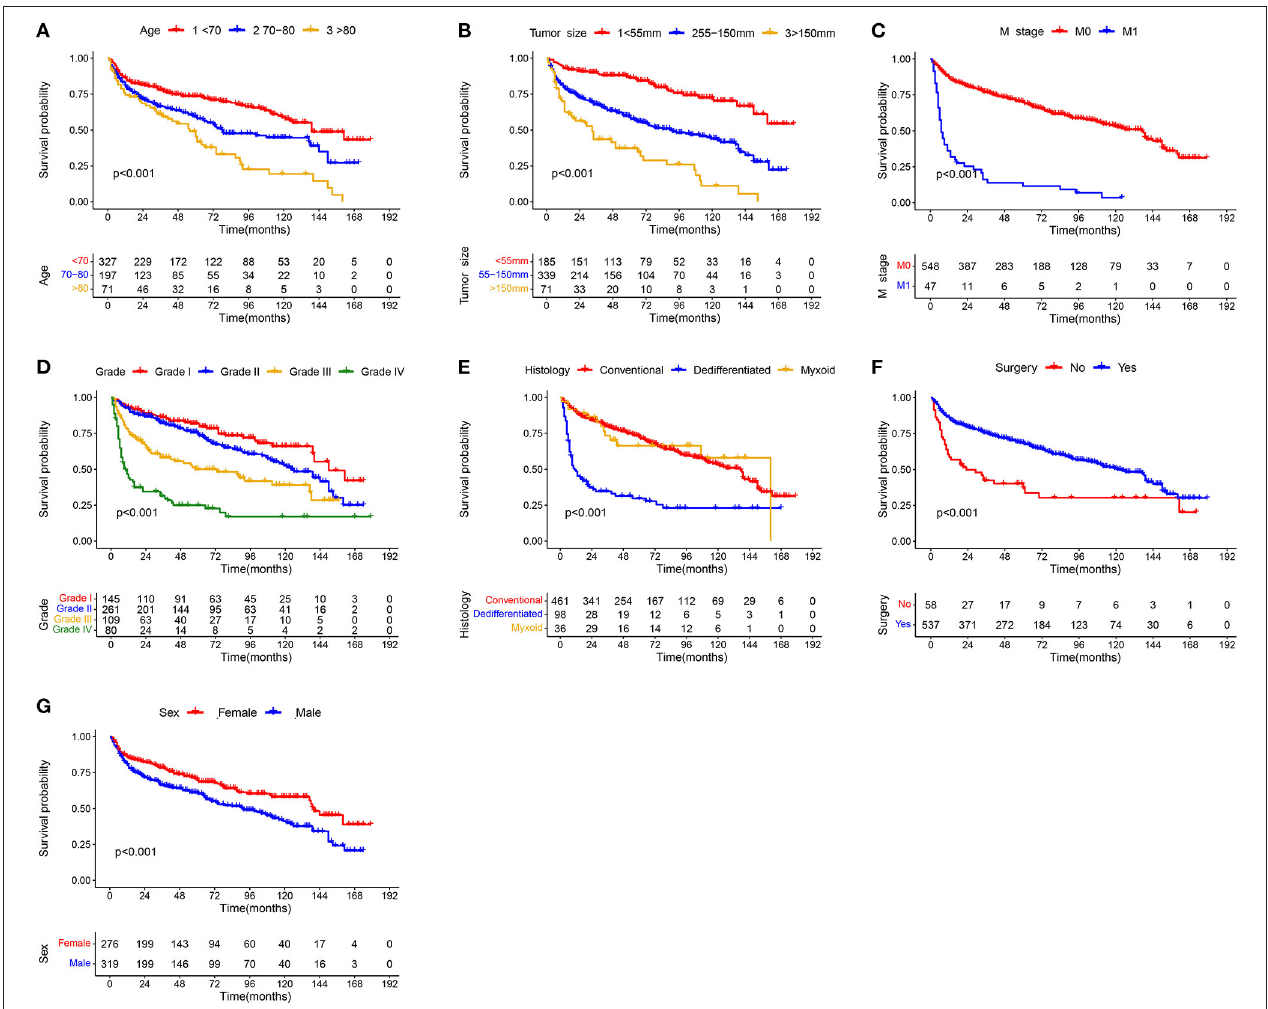
FIGURE 2 | Kaplan–Meier survival curves of variables were performed for elderly patients with CHS: (A) age, (B) tumor size, (C) M stage, (D) grade, (E) histology, (F) surgery, and (G) sex.